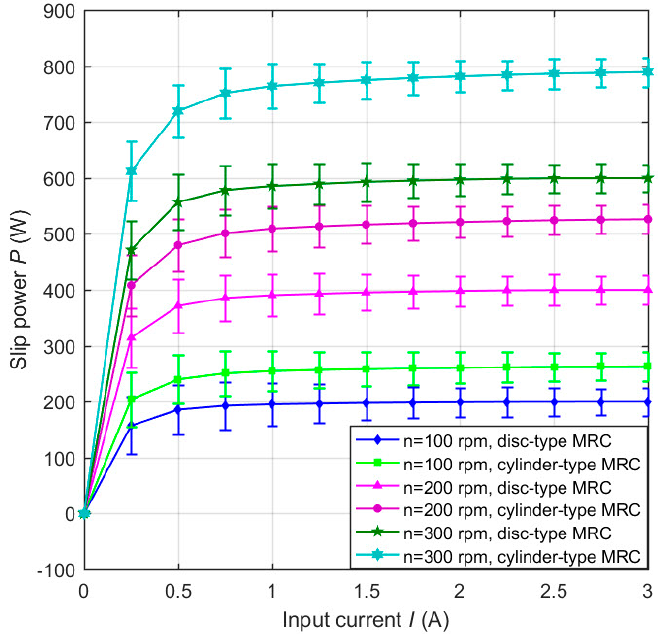
Figure 11. Effects of the input current and rotational speed difference on the slip power of the